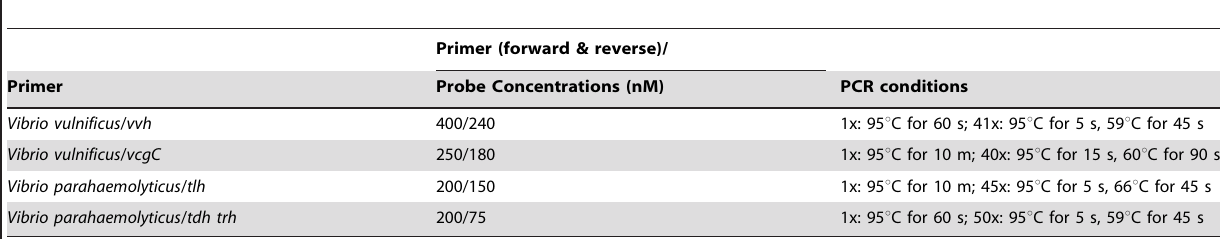
Table 1. PCR conditions for the detection of V. vulnificus and V. parahaemolyticus virulence genes.